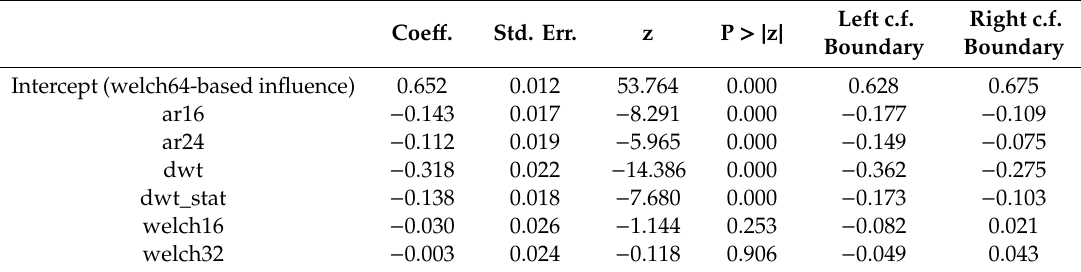
Table 9. Coe ffi cients of a linear model calculated by the analysis procedure, standard error, statistic, and p -value of a test for statistical significance as well as left and right boundaries of the confidence interval for the influence of each algorithm in comparison to the reference algorithm (welch64). Boundary probabilities of the confidence interval are 0.025 and 0.975. Coe ff